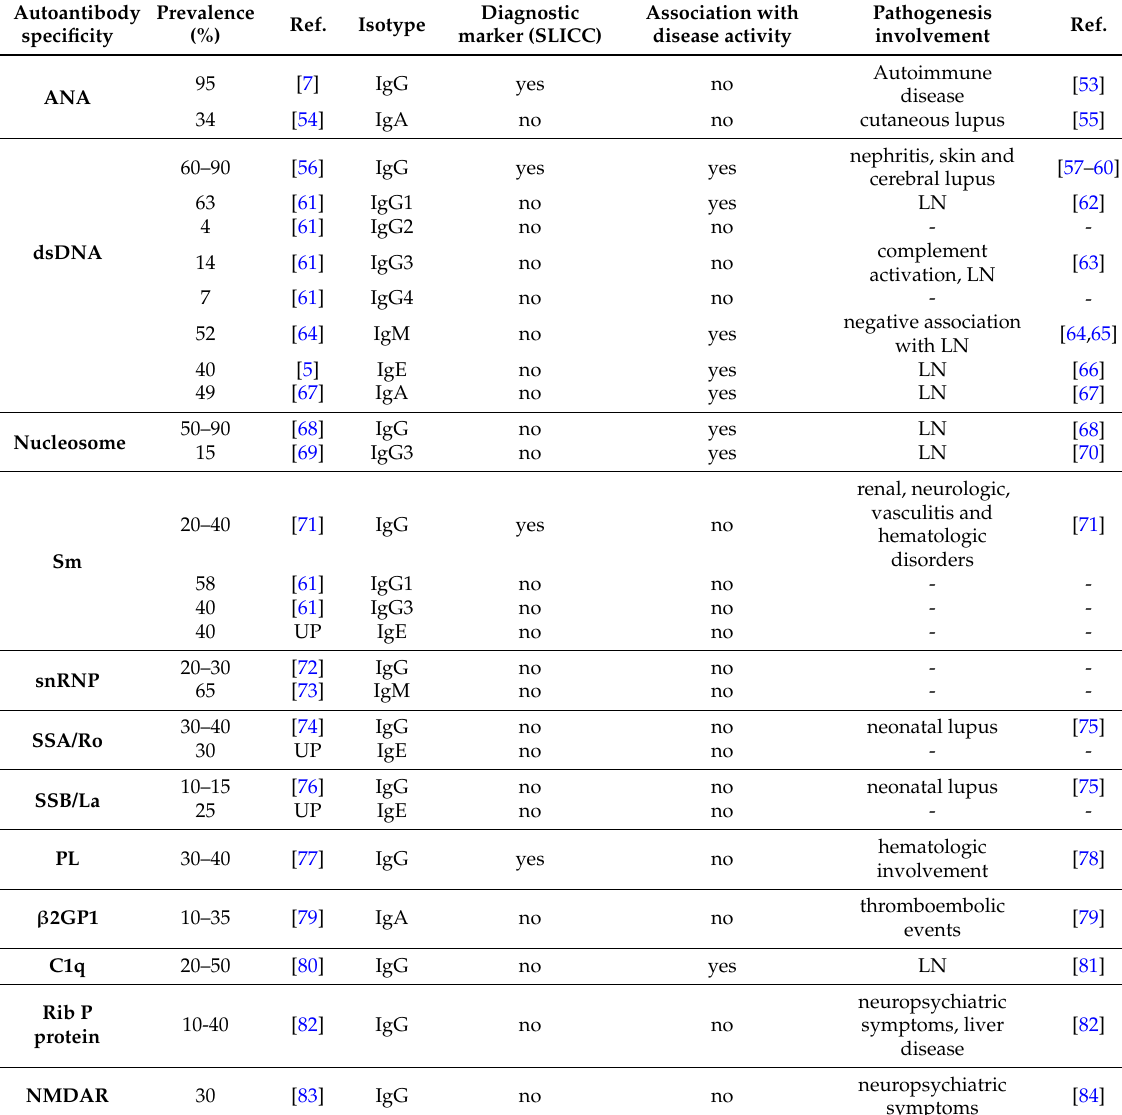
Table 1. Common self-reactive antibodies and their isotype-differential pathogenic mechanisms described in Systemic Lupus Erythematosus